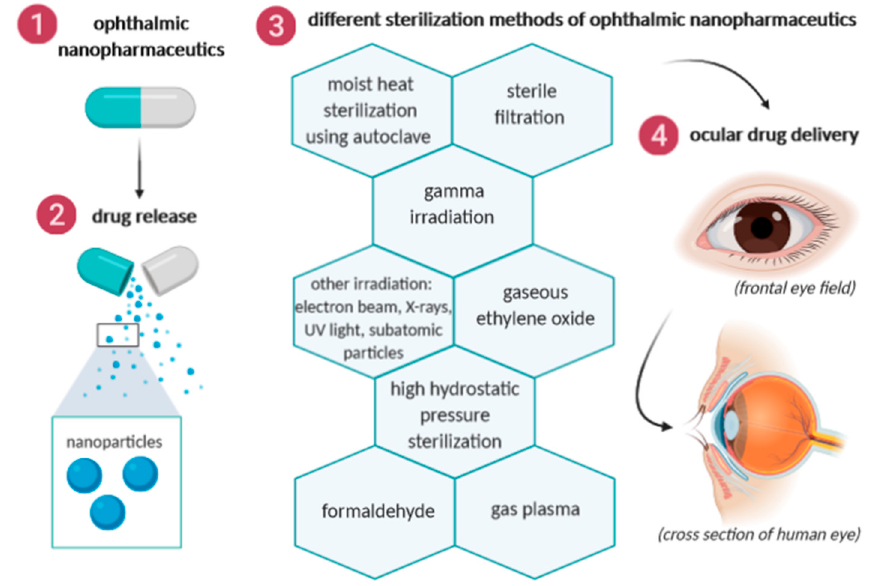
Figure 2. Different sterilization methods of ophthalmic nanopharmaceuticals. Figure 2. Di ff erent sterilization methods of ophthalmic